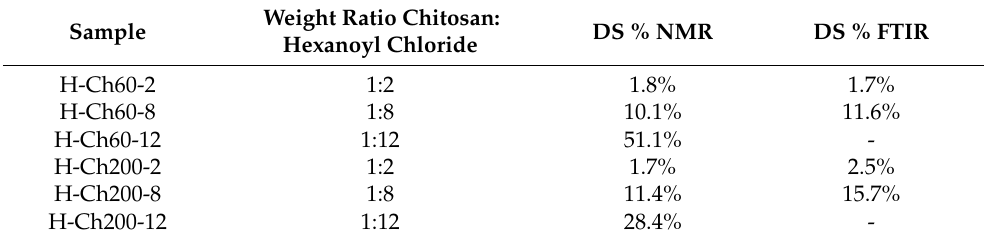
Table 2. Degree of substitution of the H-chitosan samples determined via NMR and FTIR, respectively [24]. Due to aggregation and solubility issues, H-Ch60-12 and H-Ch200-12 were not determinable with the FTIR